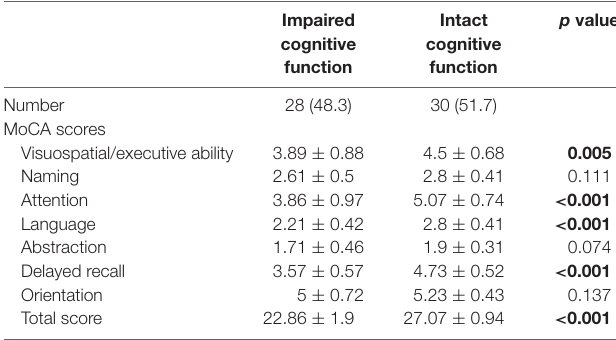
TABLE 2 | Classification of patients with aSAH based on cognitive